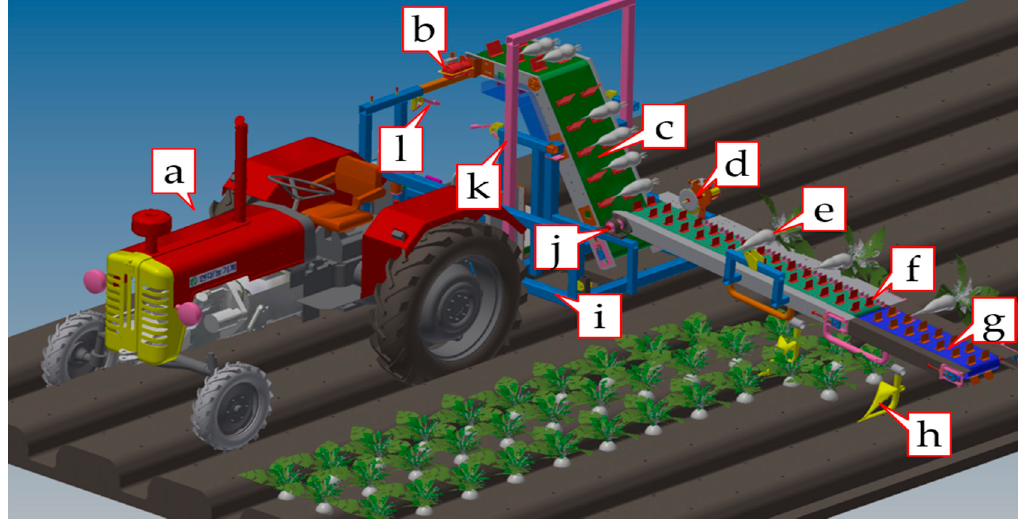
Figure 1. 3-dimensional model of the tractor-mounted radish collector system showing the major components: ( a ) tractor, ( b ) second conveyor motor, ( c ) second conveyor belt, ( d ) stem cutter ( e ) radish, ( f ) rubber bit, ( g ) first conveyor belt, ( h ) furrow guide, ( i ) collector-base, ( j ) first conveyor motor, ( k ) safety frame, and ( l ) hanging rods of the radish collecting bag.